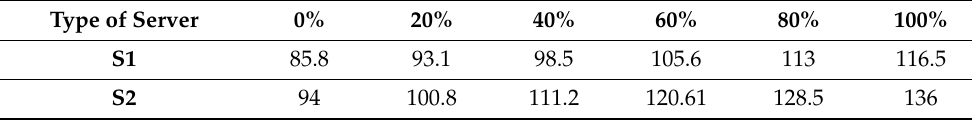
Table 3. Energy utilization at S1 and